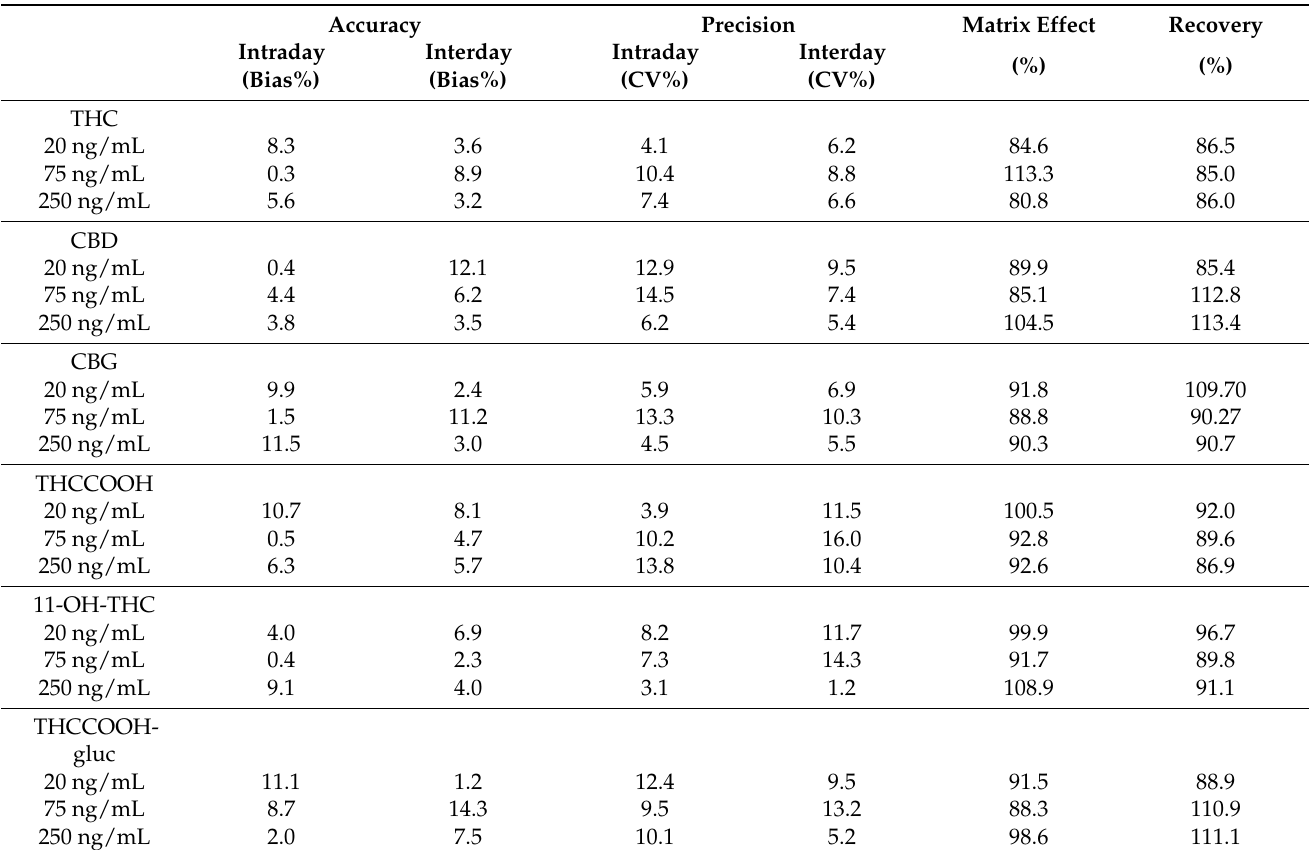
Table 3. Validation parameters of all the detected